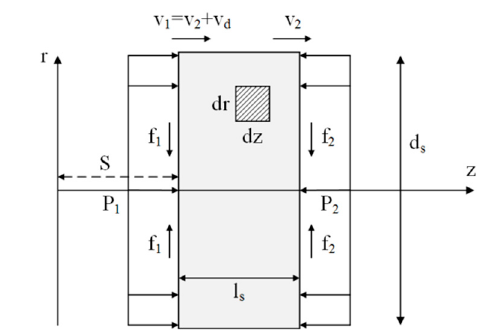
Figure 4. Analysis model of the inertial effect of the specimens in SHPB tests. d s and l s are the diameter and the thickness of a specimen, respectively. S is the reference position in the axial coordinate; v 1 and v 2 are the velocities at specimen ends. v d is the deformation velocity of a specimen; P1 and P2 are the pressure forces on the interaction surface between the specimen and bars. f 1 and f 2 are the friction forces caused by P1 and P2.